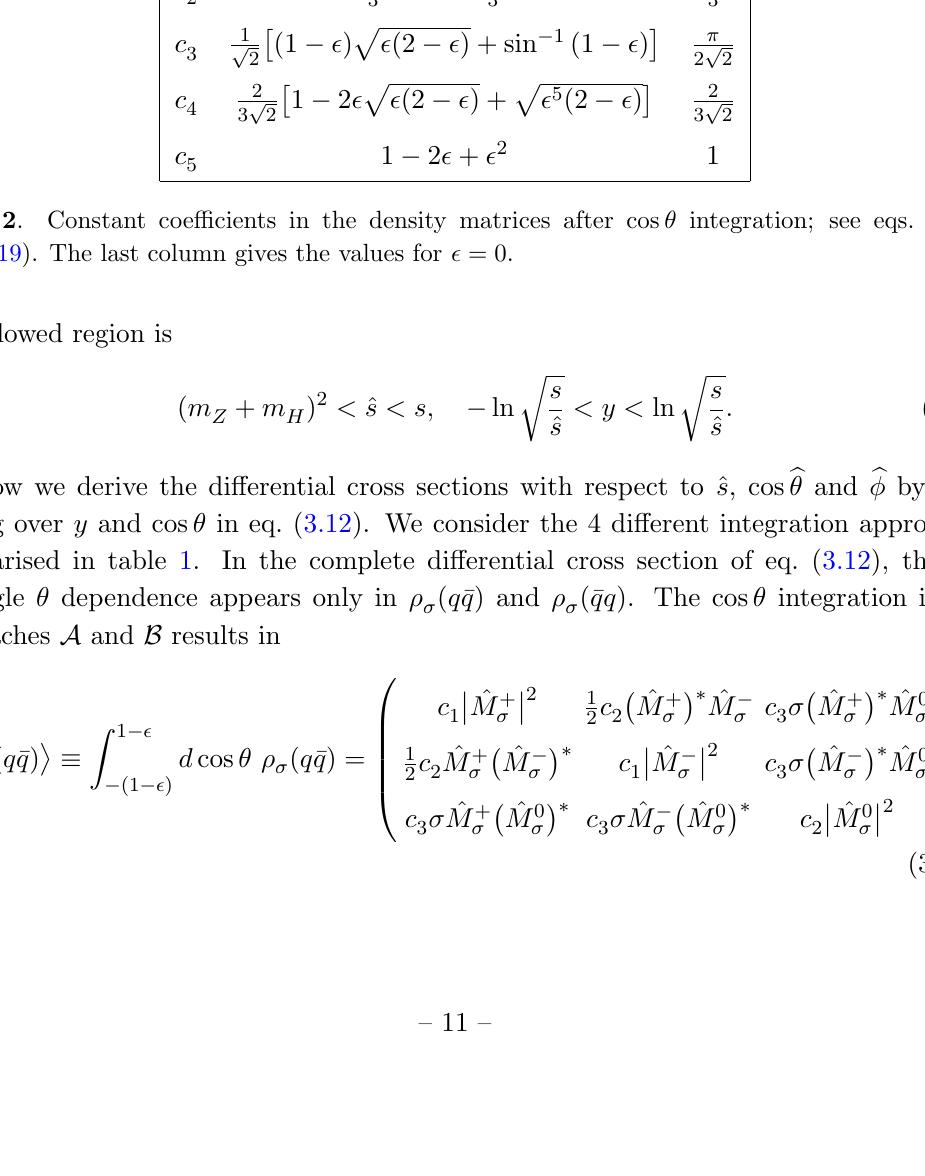
is cut (cid:15) < 1) will (cid:20)